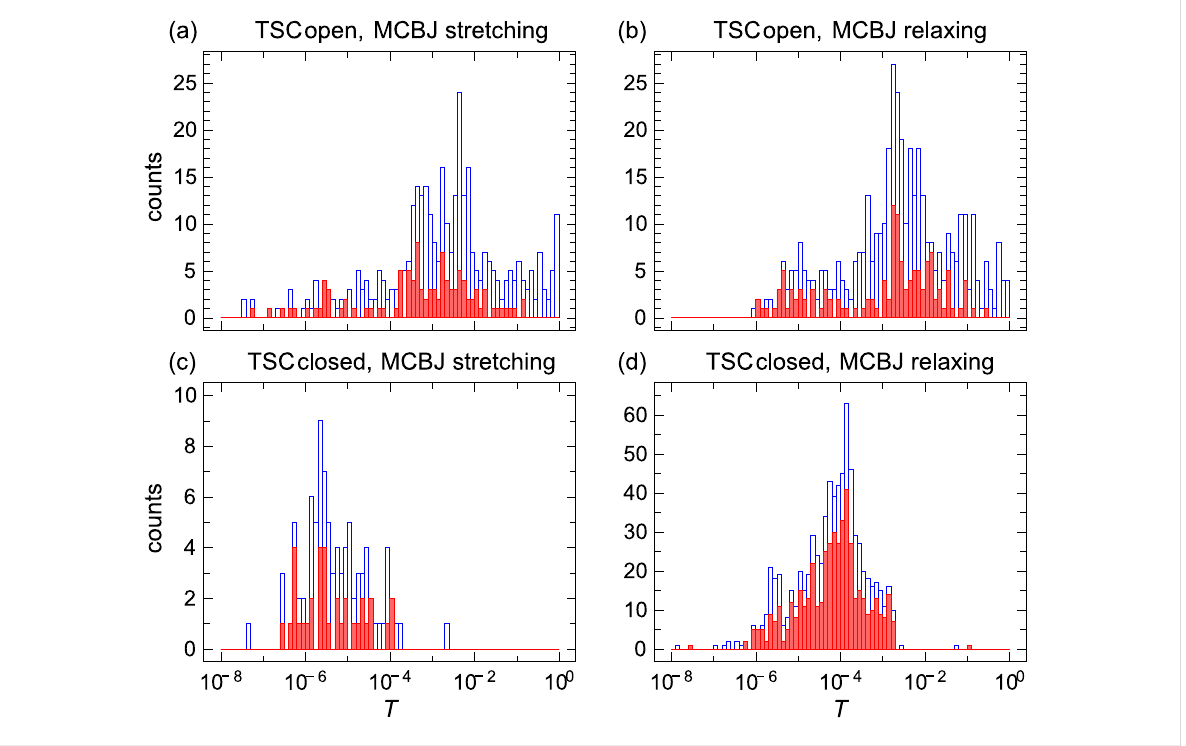
Figure 3: Transmission histograms of TSC. The open columns represent the transmission values from all I – V ’s, the closed columns only from those I – V ’s that are successfully described by the single-level model (symmetric as well as asymmetric). Panels (a) and (b) are for the closed isomer, panels (c) and (d) for the open isomer. The data shown in panels (a) and (c) were recorded during stretching of the junctions, the data in panels (b) and (d) during relaxing of the